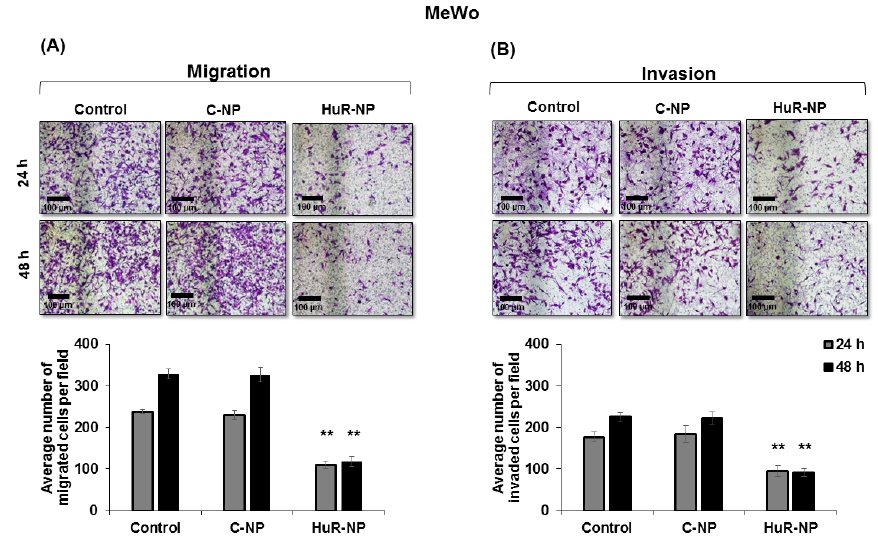
Figure 5. HuR-NP reduced melanoma cell migration and invasion. Representative images of crystal violet stained MeWo cells in ( A ), migration, and ( B ), invasion assay. Bar graphs represent the quantification of migrating and invading cells. Scale bar 100 µm. Error bar denotes SD; ** p < 0.01.